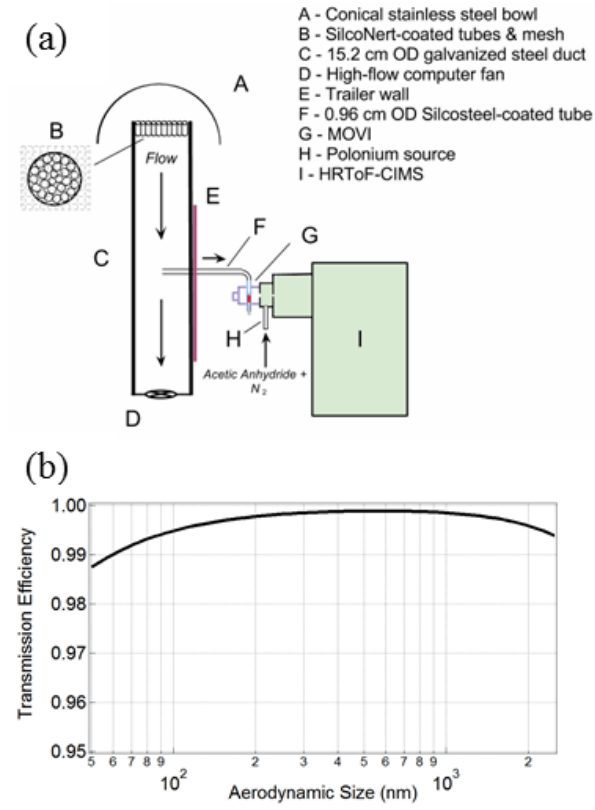
Fig. 1. (a) Schematic of the sampling inlet used during the BEACHON-RoMBAS study, (b) calculated aerosol transmission efficiency of the complete inlet vs. aerodynamic